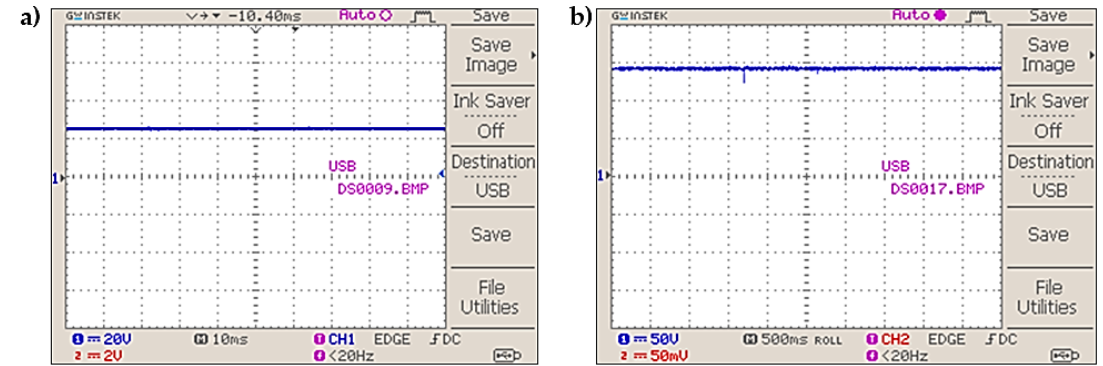
Figure 16. ( a ) Solar panel output voltage waveform; ( b ) Modified LUO converter output voltage waveform.